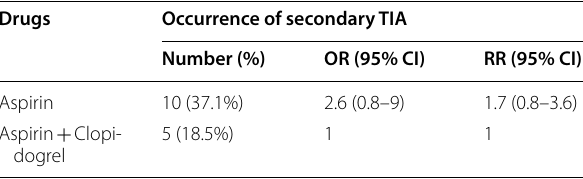
Table 3 Odds ratio (OR) and risk ratio (RR) of secondary TIA in each group